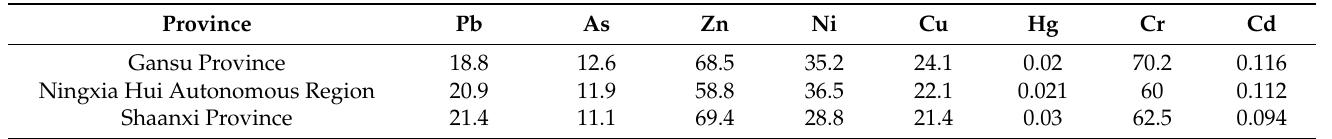
Table 2. Background values of heavy metals in soils of administrative regions in the Weihe River Basin [29]/(mg · kg − 1 ).